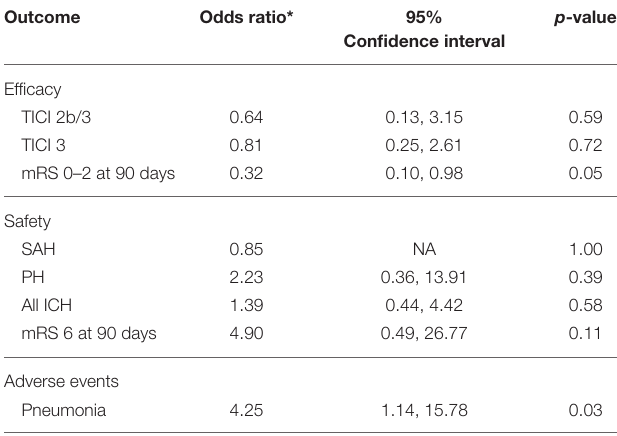
TABLE 3 | Regression logistic model adjusted using the method of propensity scores comparing GA-policy with CS-policy as the independent variable of